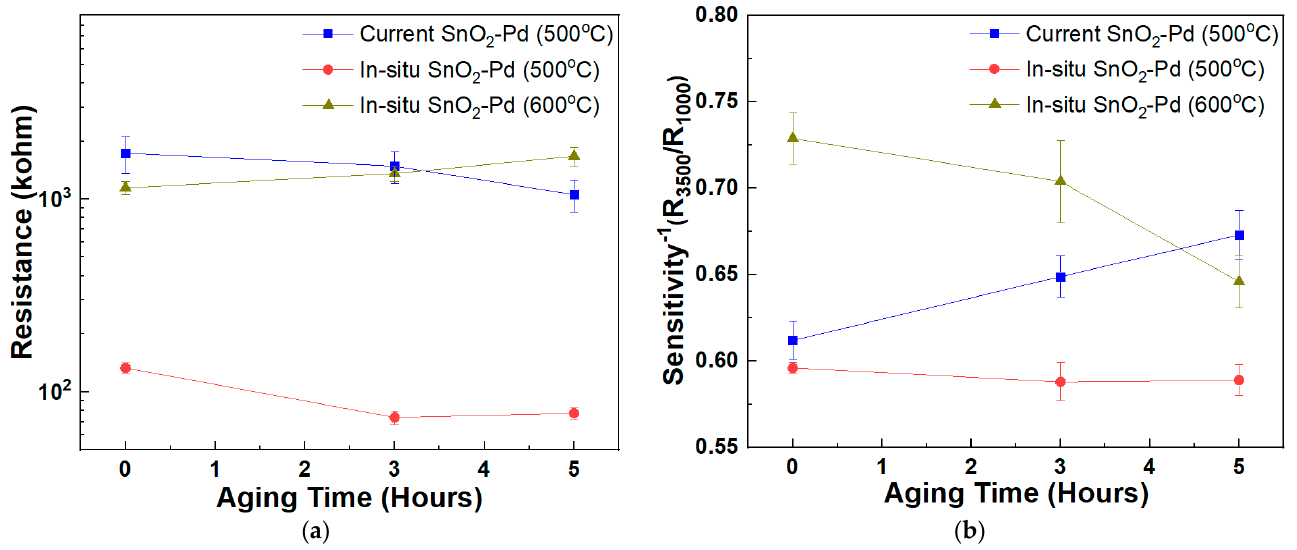
Figure 7. ( a ) Resistances and ( b ) sensitivities of gas sensitive thick films containing SnO 2 -Pd NPs synthesized with current method, in situ method at 500 °C and in situ method at 600 °C, respec- tively.